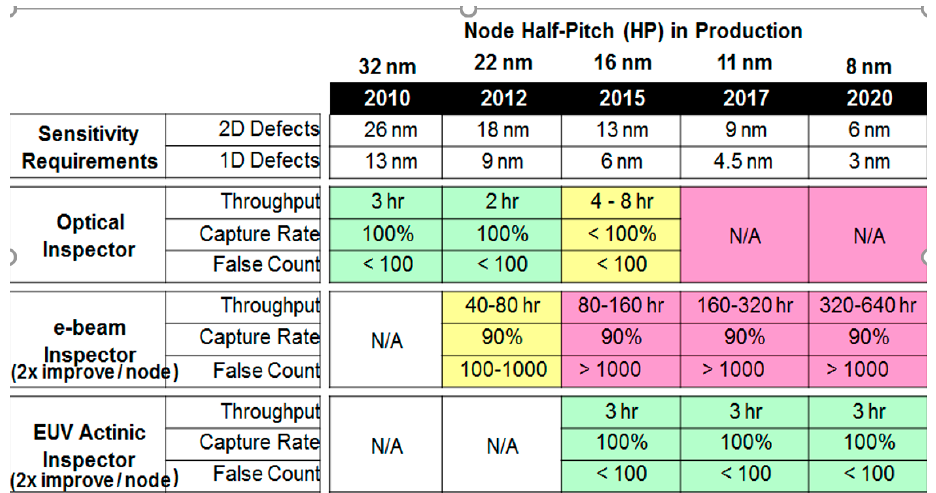
Figure 28. Various nodes and related technology fulfillment.